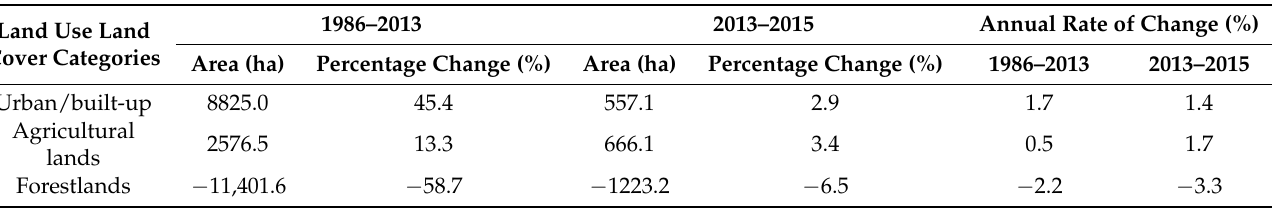
Table 4. Changes in Area and